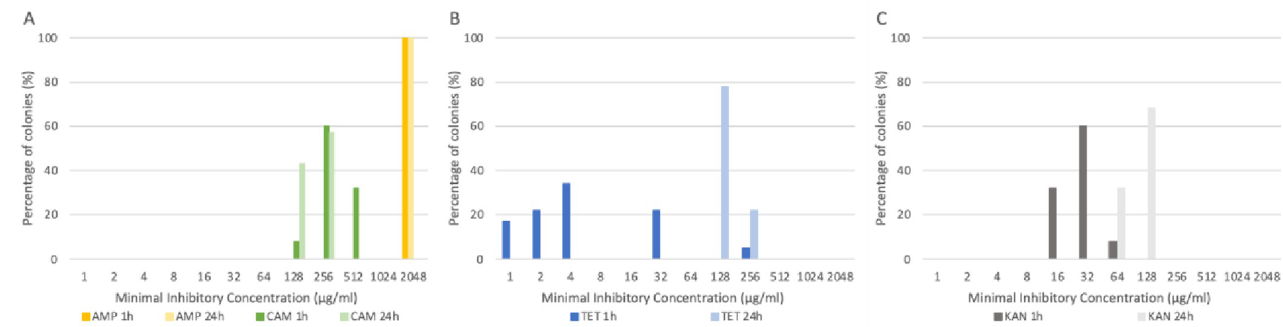
Fig 4. The percentage of isolated colonies found with a specific minimal inhibitory concentration (MIC) for antimicrobials: ampicillin and chloramphenicol ( A ), tetracycline ( B ) and kanamycin ( C ) after co-incubation of E . coli MG1655 and E . coli ESBL2082 for 1 hour or 24 hours and plating on double selective plates with ampicillin and